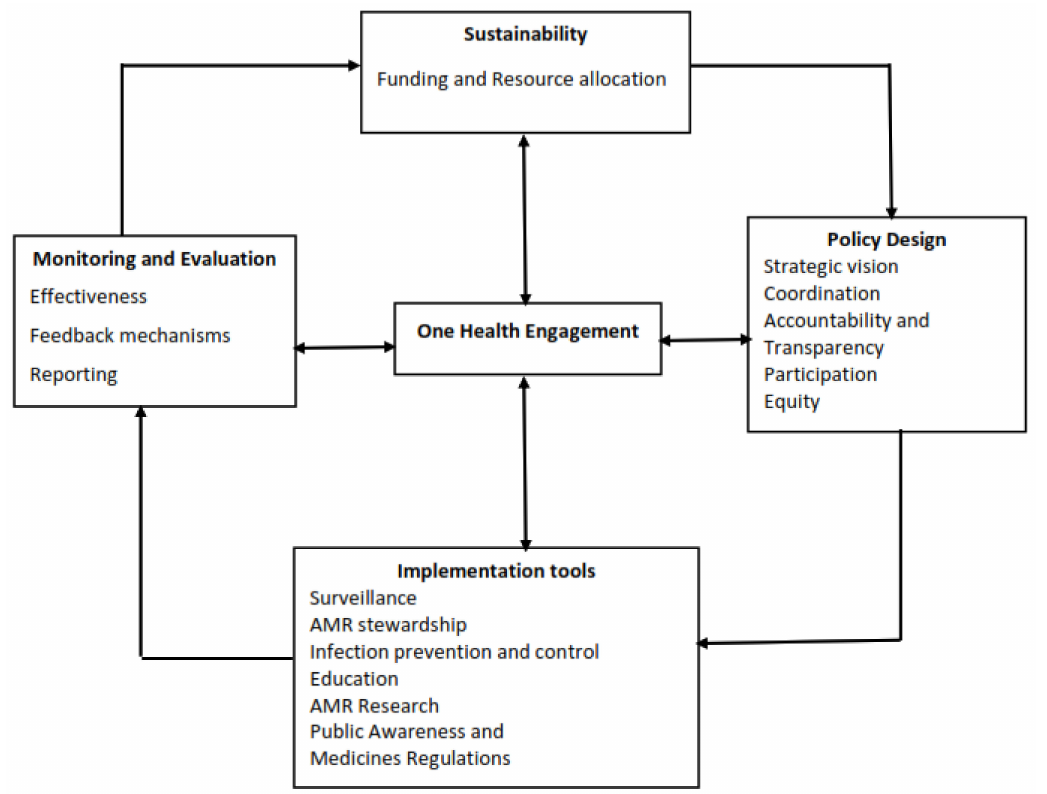
Figure 1. Antimicrobial resistance (AMR) governance framework with four areas and 15 domains adapted from Chua et al.,